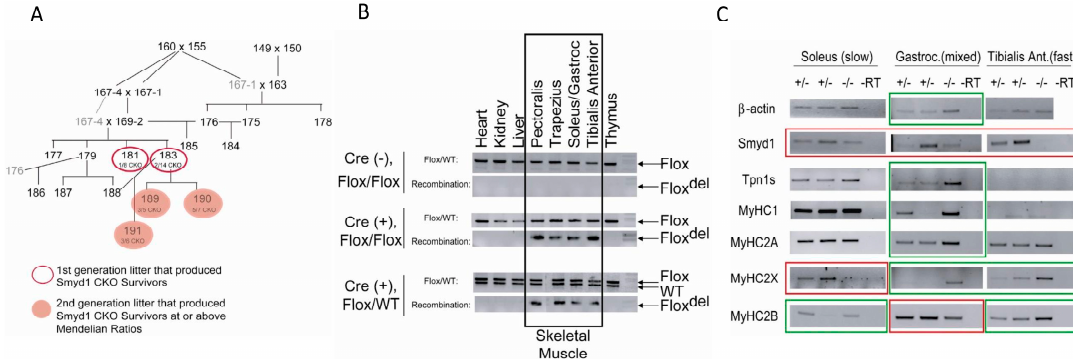
Figure 5. SMYD1 controls specification of muscle fiber-type in rare adult survivors. ( A ) A heritable change within the Smyd1 locus allowed some MyoG-Cre/Smyd1 (CKO) mice to survive. Mice were bred in a non-gender specific manner by intercrossing Smyd1; Cre Flox/Flox mice. Two of four litters from a mother-son cross yielded several CKO pups of this genotype. Further crossing of these lines produced CKO pups at or above expected Mendelian ratios. Pups within a litter are indicated in open (first generation) and orange (second generation) circles. Numbers in gray are duplications necessary to show breeding within multiple partners. ( B ) Recombination occurs specifically within skeletal muscle of MyoG-Cre + Smyd1 Flox/Flox (CKO) survivors. Mice were sacrificed, DNA was extracted from their tissues and analyzed via endpoint PCR at postnatal day (P12). Recombination specifically is confirmed as both the Cre transgene and Smyd1 flox allele are present. ( C ) Slow/fast fiber type composition is altered in adult Smyd1 -deficient skeletal muscle survivors. Mice were sacrificed, RNA was prepared and subjected to end-point RT-PCR analysis. Selective isolation of slow vs. fast muscle is indicated by absence of the slow markers, Troponin1 and MyHC1, in the fast muscles. Heterozygotes express variable levels of SMYD1 (e.g., compare values of all left-side columns to those in the middle). Smyd1 KO in the soleus muscle is less efficient than in other muscles. Expression levels of MyHC2X and MyHC2B are altered in all three muscle types. In slow muscle, MyHC2x expression levels directly correlate to those of SMYD1, whereas in mixed (slow + fast) gastrocnemius, MyHC2x is indirectly correlated with SMYD1 levels. MyHC2B levels are indirectly correlated with SMYD1 levels in slow and fast tissues, whereas they are directly correlated in mixed tissue. These results are representative of three independent measurements